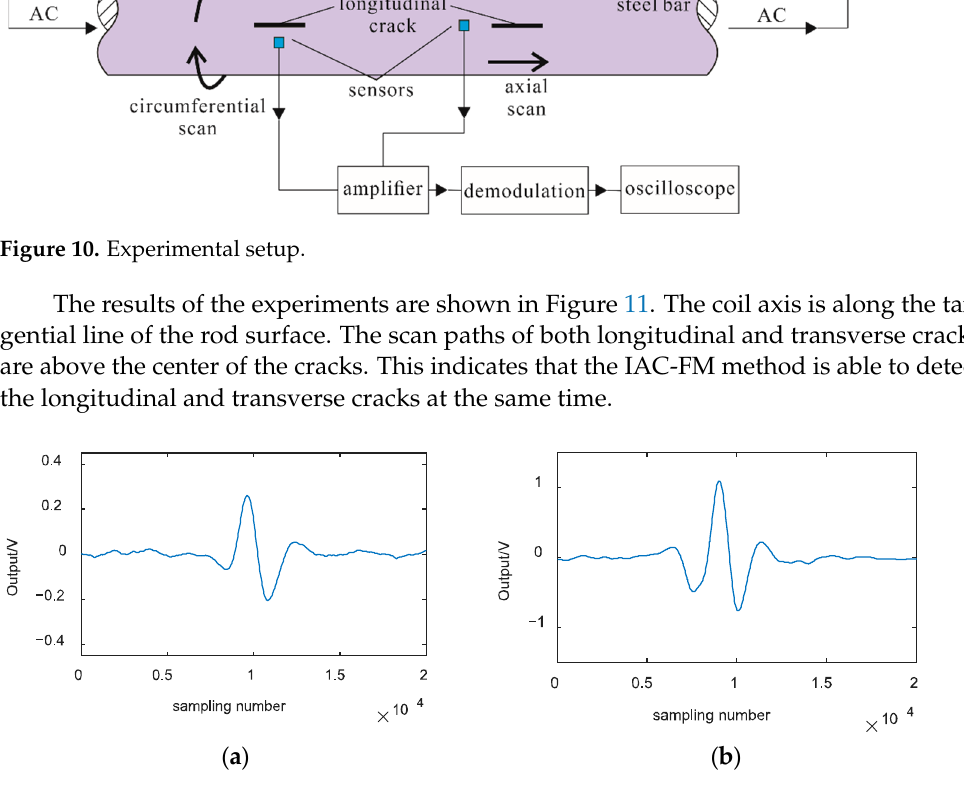
Figure 11. Testing signals of longitudinal and transverse cracks: ( a ) longitudinal crack; ( b ) trans- verse crack.